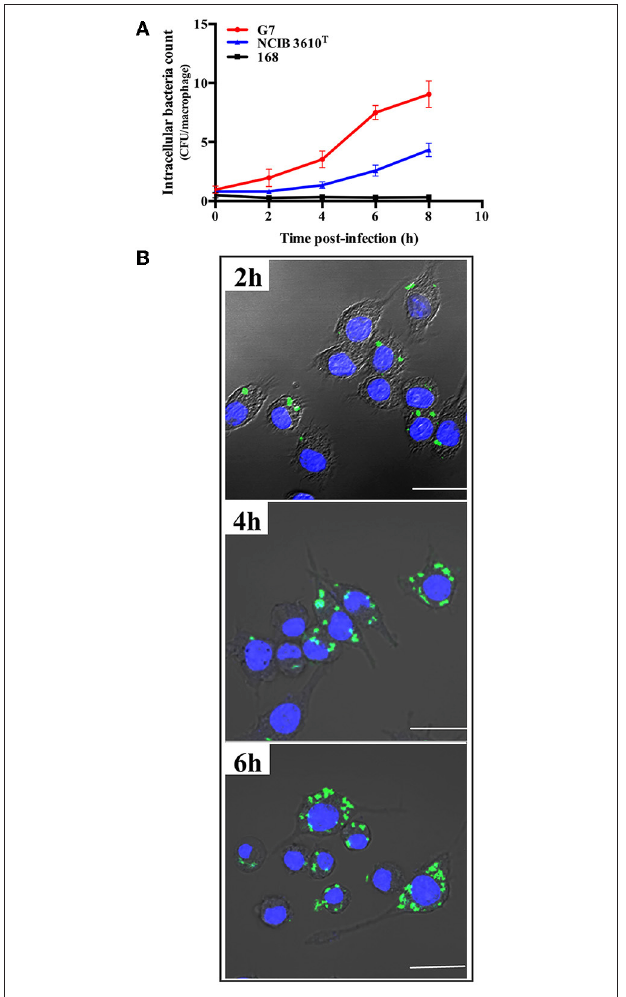
FIGURE 7 | Replication of G7 in macrophages. (A) RAW264.7 cells were infected with G7, NCIB 3610 T , and strain 168 for 2h, and extracellular bacteria were killed by antibiotics. The cells were cultured further for 2, 4, 6, and 8h, and intracellular bacterial number was determined by plate count. The results are the means of three experiments and shown as means ± SEM. (B) Microscopic observation of RAW264.7 infected with G7 as above. G7 and RAW264.7 were stained with CFDA-SE (green) and Hoechst 33258 (blue), respectively. Bar, 10 µ m.